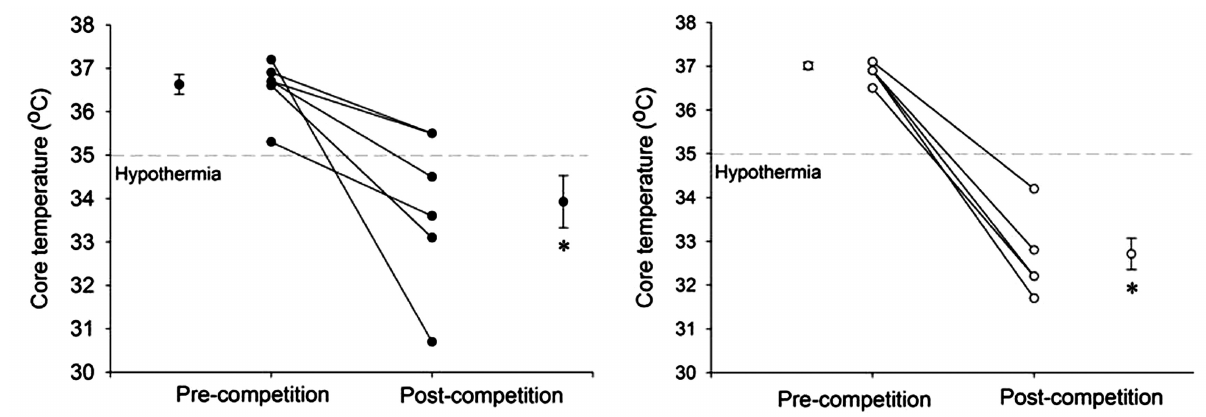
Figure 1 - Individual core temperature of male (n=7; left panel) and female (n=5; right panel) athletes before and after a 10-km open-water swimming competition. Outer symbols are mean ± SE. * P < 0.01 vs. pre-competition data in the same group. Dotted line shows the limit for hypothermia Table 1 - Anthropometric and competition data of athletes